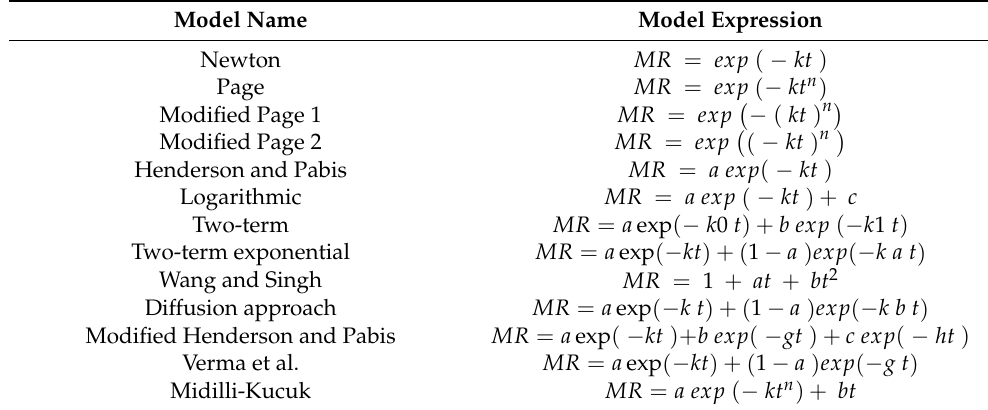
Table 1. Mathematical models applied to drying curves